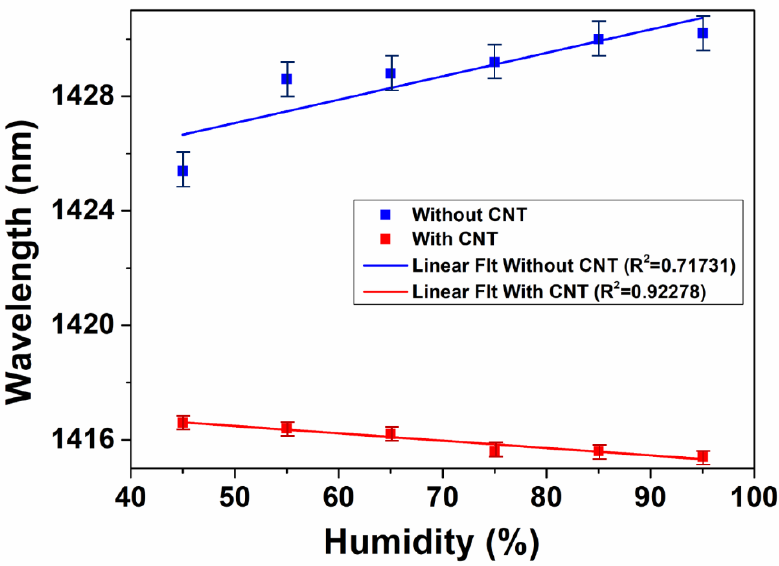
Figure 8. The relationship and linear fitting between RH and interference dip wavelength without (blue line) and with (red line) CNT attached.